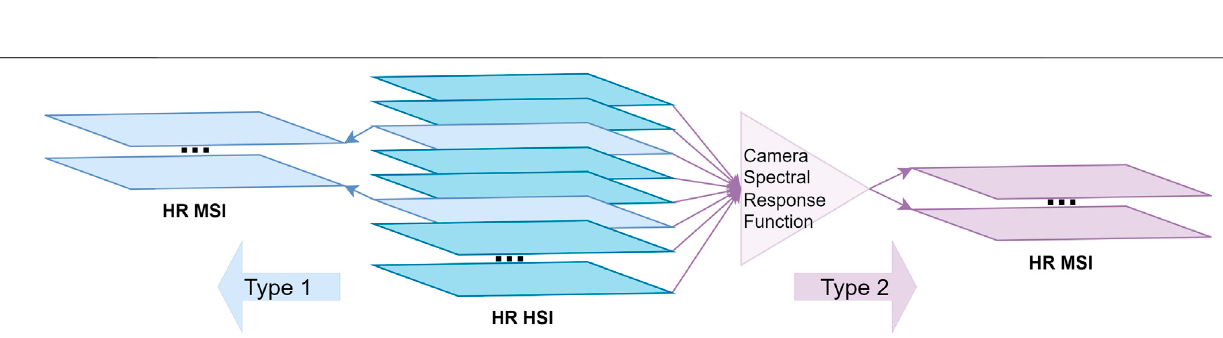
FIGURE 1 | MSSR-NET architecture. The operation types are written in each block and the arrows with plus sign denote skip-connections. The blue arrows and blocks are our modi fi cations to the baseline scheme.